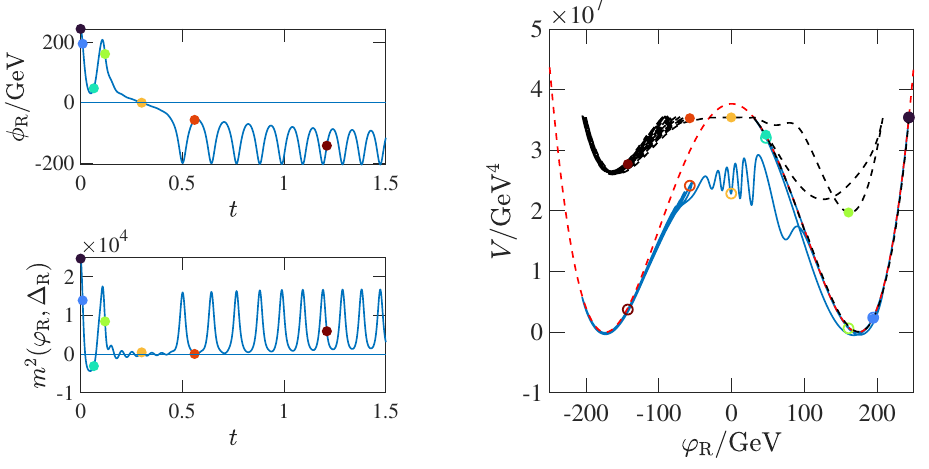
Figure 6 . The upper left panel shows the time evolution of ϕ R (in units GeV) and the lower left panel that of the effective mass function m 2 ( ϕ R , ∆ R ) (in units GeV 2 ) in the case of a strong spinodal instability. In the right panel we show the time-evolution of the instantaneous effective potential (5.4) (dashed black line), embedded in a plot of the vacuum Hartree potential (dashed red line). The colored dots indicate select times at which the instantaneous potential was evaluated as indicated in the left panels. The solid blue line shows the instantaneous value of the non-equilibrium vacuum potential